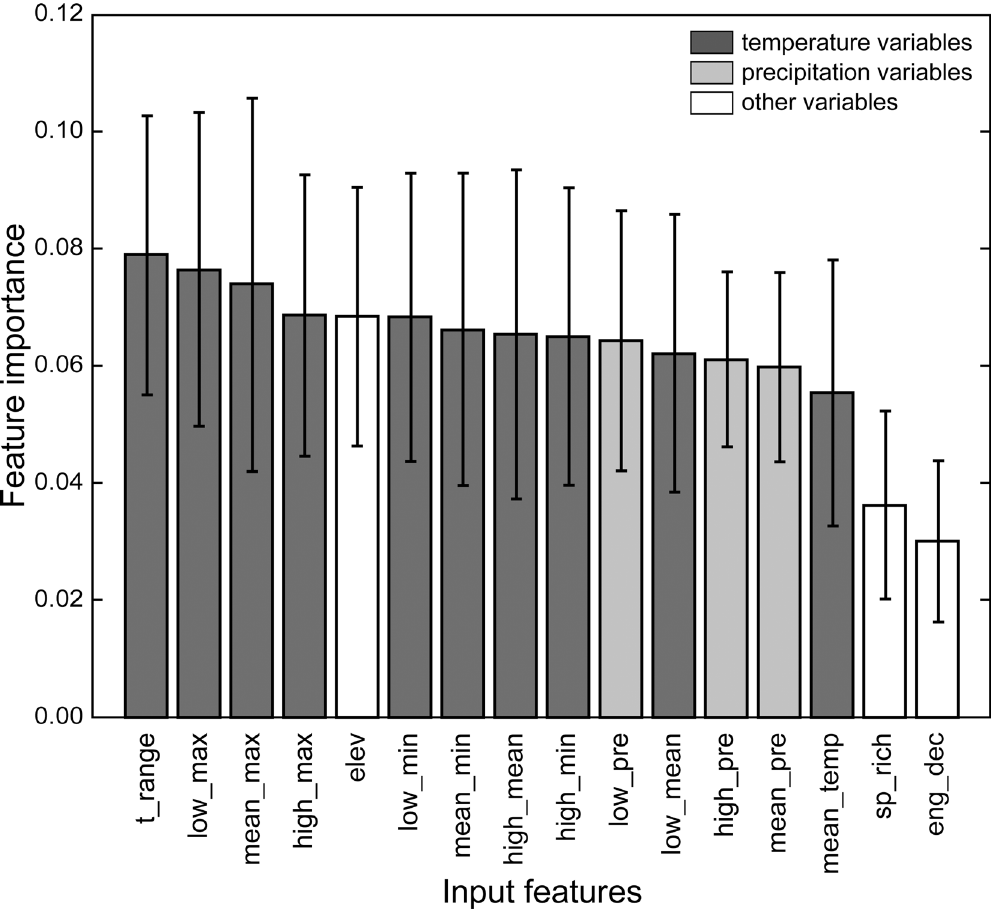
Fig 2. Relative importance of input features based on non-region specific (global) model of amphibian chytrid fungus ( Batrachochytrium dendrobatidis ) occurrence. Relative importance of an input feature for global Batrachochytrium dendrobatidis occurrence was estimated as an increase in out-of-bag error if training values for that feature were permutated. Plots indicate one standard deviation to show variation between trees in the random